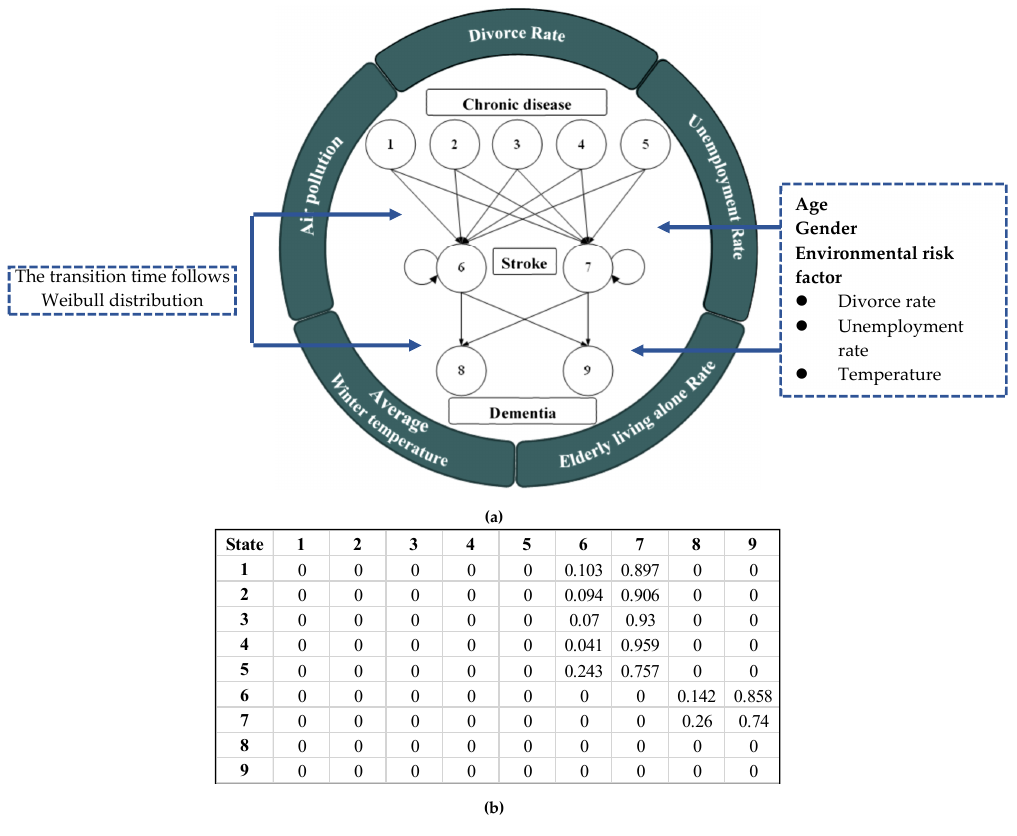
Figure 2. ( a ) Probability transition matrix; ( b ) The transition probability matrix in the SMP model. Figure 2. (a) Probability transition matrix; (b) The transition probability matrix in the SMP model. Table 4. The number of states and descriptions in the SMP